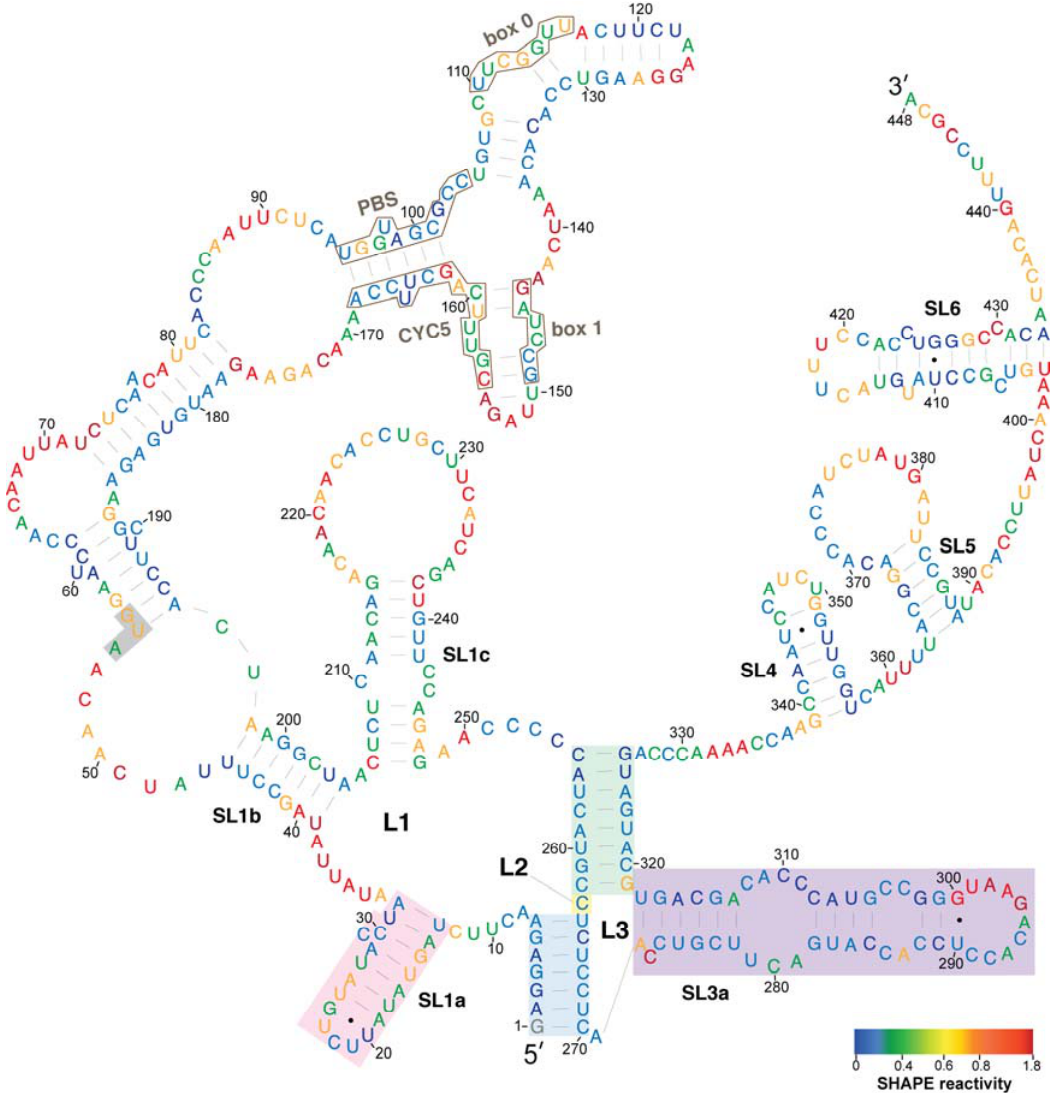
Figure 2. SHAPE reactivities and secondary structure model of the 5 ′ leader of Ty1 RNA. Nucleotides are colored according to their SHAPE reactivities, which are indicated on the color bar at the bottom left. Regions of low reactivity have a high probability of being constrained within secondary or tertiary structure. The AUG nucleotides shaded in grey comprise the start codon of GAG . The pseudoknot core contains stem S1 (blue shading), loop L2 (nucleotide 263, yellow shading), and stem S2 (green shading). Pseudoknot loops L1 (nucleotides 9–254) and L3 (nucleotides 271–318) are not shaded. The SL1a hairpin (pink shading) and SL3a hairpin (purple shading) are indicated.